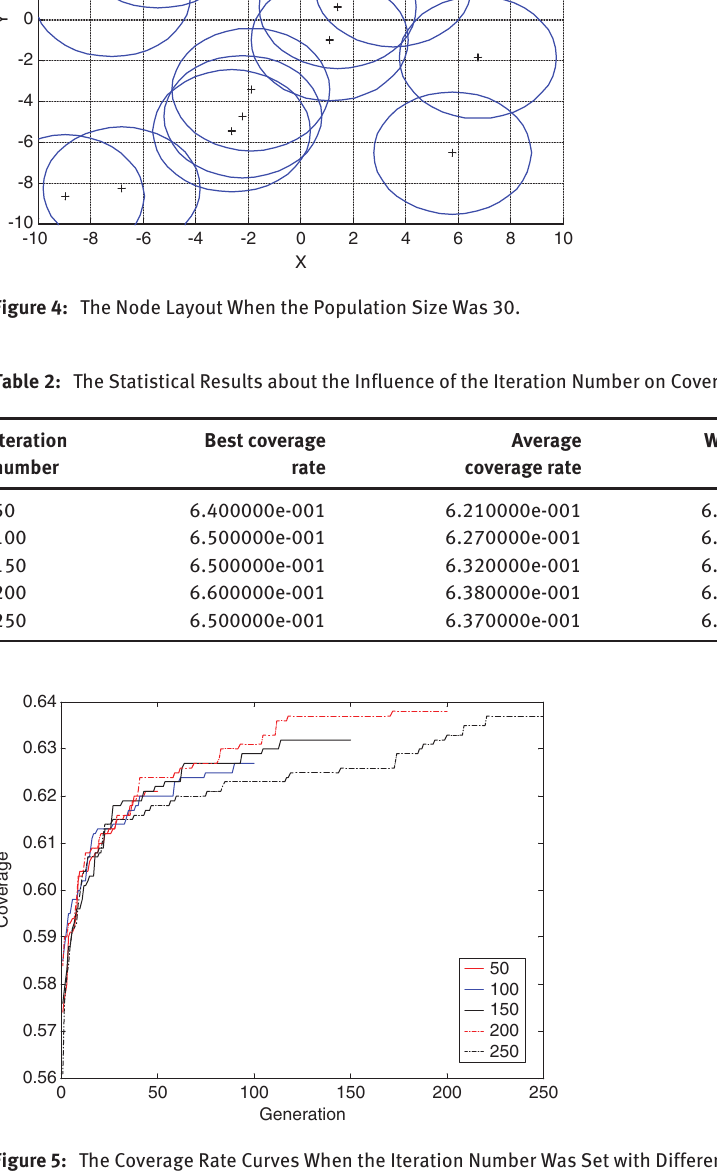
increasing. Figure 7 is the wireless sensor nodes layout when the iteration number is 200. When the iteration number is 200, both the best coverage rate and the average rate are the biggest; when the iteration number is 250, the worst coverage rate is the biggest and the variance is the